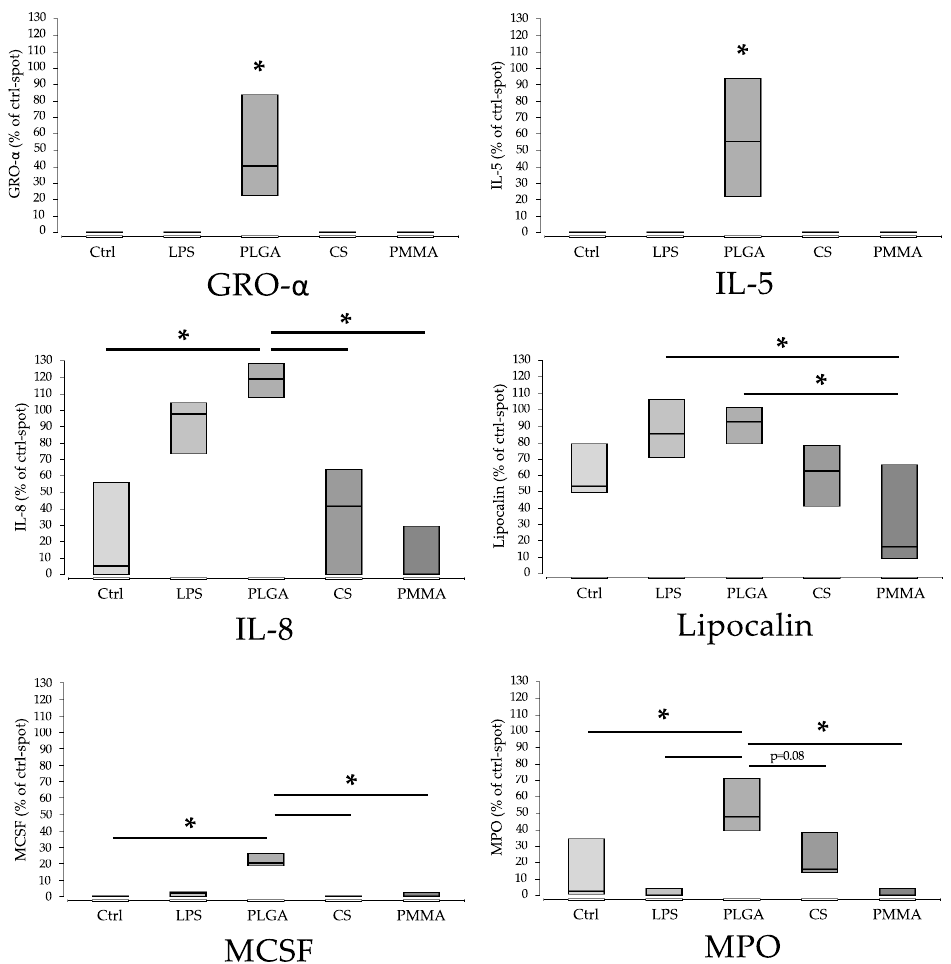
Figure 5. The sample materials induced significantly different proteins during WBSA. The values are normalised to the density of the ‘control’ spots (ctrl) (=100%). For PLGA significantly elevated protein concentrations were found for Gro- α , IL-5, IL-8, lipocalin, M-CSF and MPO. LPS alone shows comparable high values for IL-8 and lipocalin. ‘*’ marks significant differences ( p < 0.05). CS, PMMA. (Ctrl: control; LPS: Lipopolysaccharide; PLGA: poly(lactic-co-glycolic acid; CS: calcium sulphate scaffold; PMMA: polymethylmethacrylate). Table 2. Expressed parameters with significant differences between groups and assignment to func- tional categories.